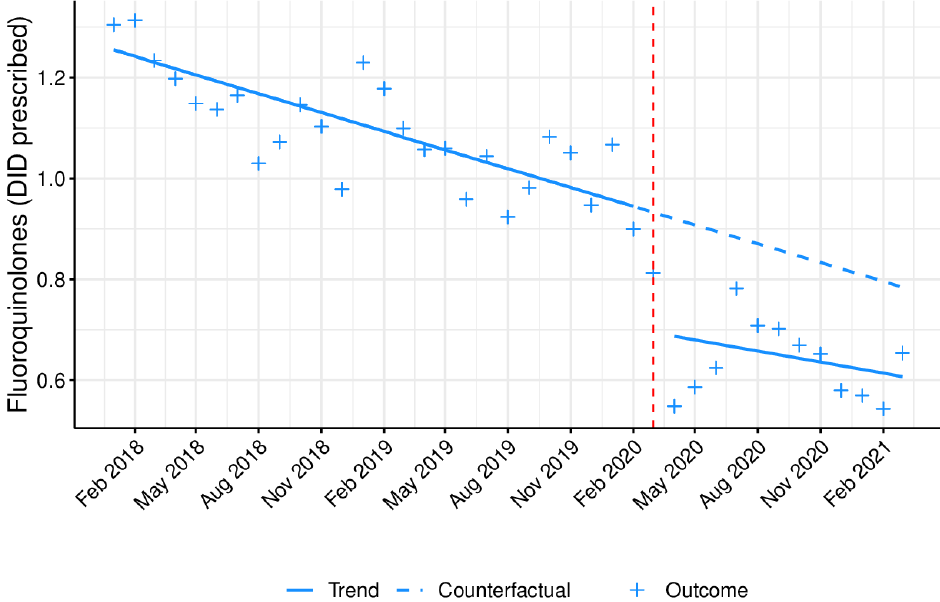
Figure 5. Monthly prescribing trend of fluoroquinolones as DID prescribed in outpatient care. Blue line (−): tendency line, after model adjustment; blue dashed line: expected tendency line with no COVID-19 emergence; red dashed line: COVID-19 emergence (March 2020); + : antibiotic monthly prescription in DID.